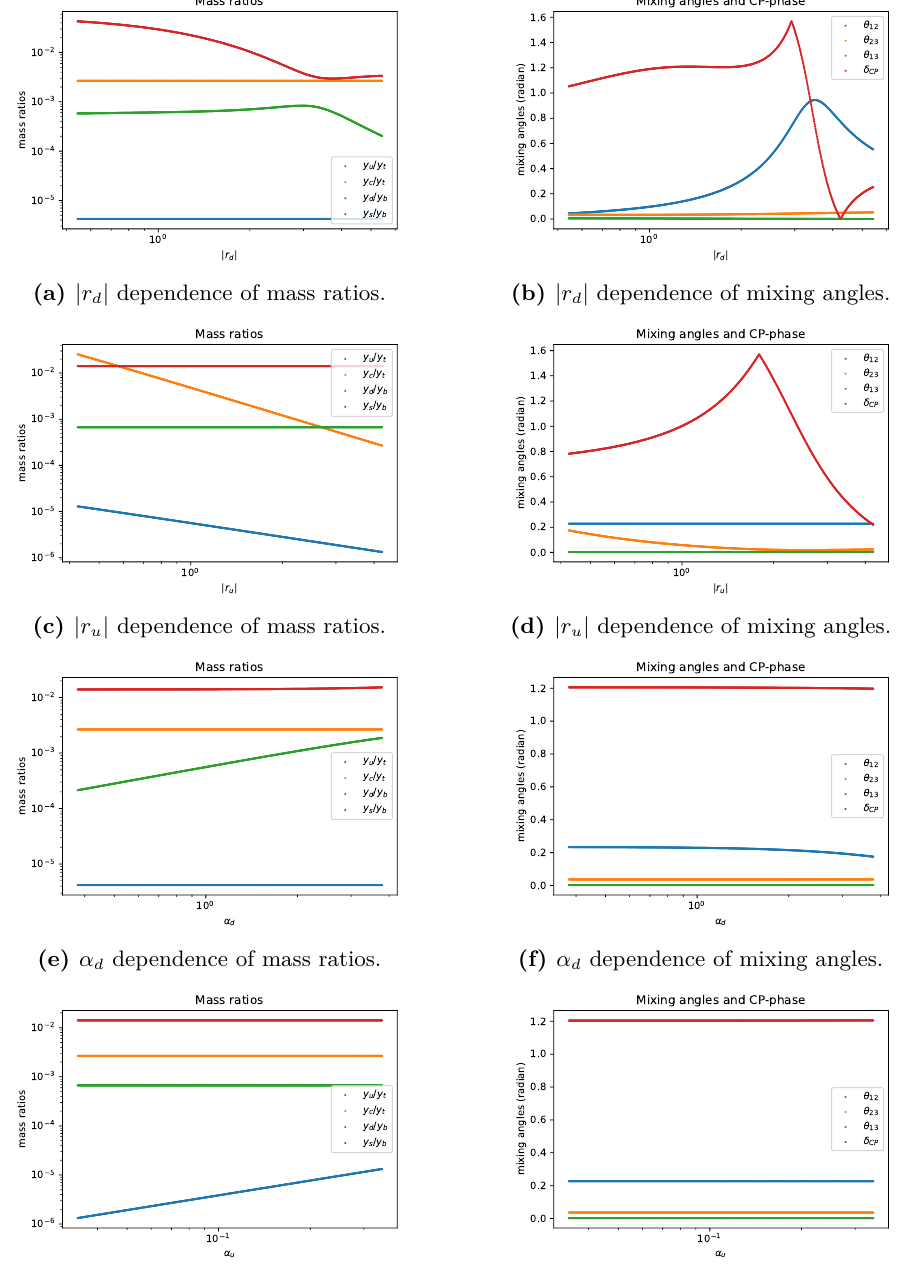
Figure 3. Parameter dependence of the mass ratios, mixing angles and CP-phase. We show | r u,d | dependence since the mixing angles are explicitly depend on them at the leading order. We also show α d and α u dependence of the parameters for comparison purpose. The observables (except for the corresponding mass eigenvalues) are almost independent of α u and α d